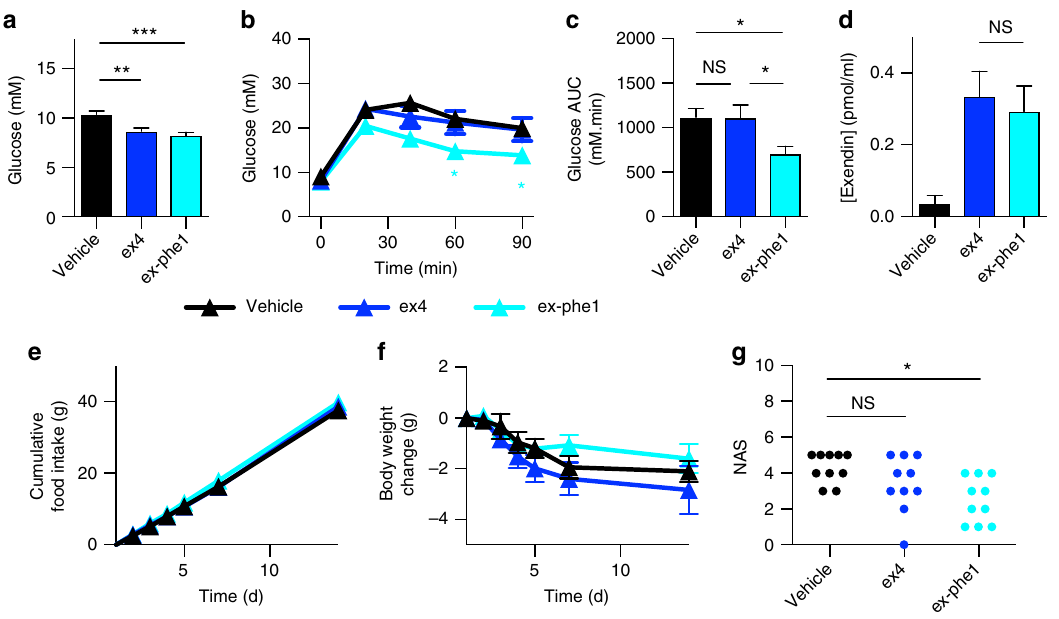
Fig. 9 Effects of chronic treatment with exendin-phe1. a Fasting blood glucose in HFHS mice treated with continuous subcutaneous agonist or vehicle for 16 days, n = 10/group, one-way ANOVA with Tukey ’ s test. b Blood glucose during IPGTT (2 g kg − 1 ) performed after 14 days continuous agonist treatment, n = 10/group, two-way repeat measures ANOVA with Tukey ’ s test, with signi fi cance for exendin-phe1 vs. exendin-4 indicated. c AUC calculated from b , relative to baseline glucose at t = 0, one-way ANOVA with Tukey ’ s test. d Plasma drug level after 16 days treatment with indicated agonist (2.4 nmolkg − 1 day − 1 ) or vehicle in lean mice, n = 5/group, unpaired t -test. e Cumulative food intake, and f body weight change with continuous administration of agonist, n = 10/group. g Histologically determined steatohepatitis, quanti fi ed as nonalcoholic activity score (NAS), after 16 days agonist administration, n = 10/ group, Kruskal – Wallis with Dunn ’ s test. Except where indicated (pharmacokinetic study), agonist administered at 0.24 nmol kg − 1 day − 1 . * p < 0.05, ** p < 0.01, ** p < 0.001, by statistical test indicated above. Error bars indicate